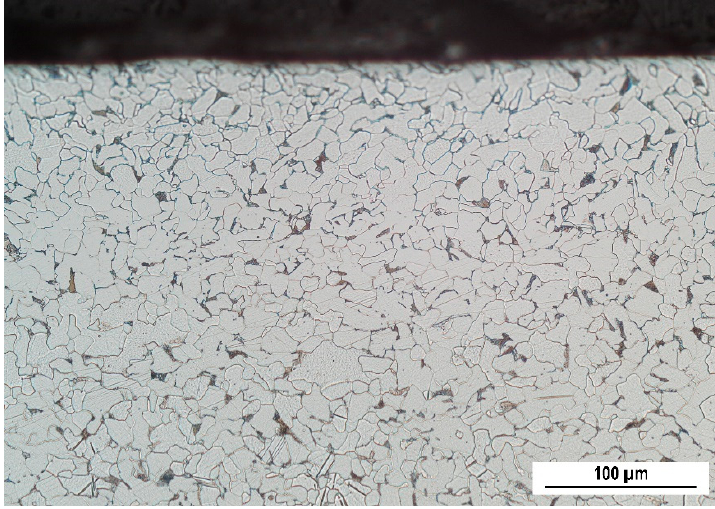
Figure 3. Ferrite matrix (white) with limited volume of pearlite islands (dark), as received.